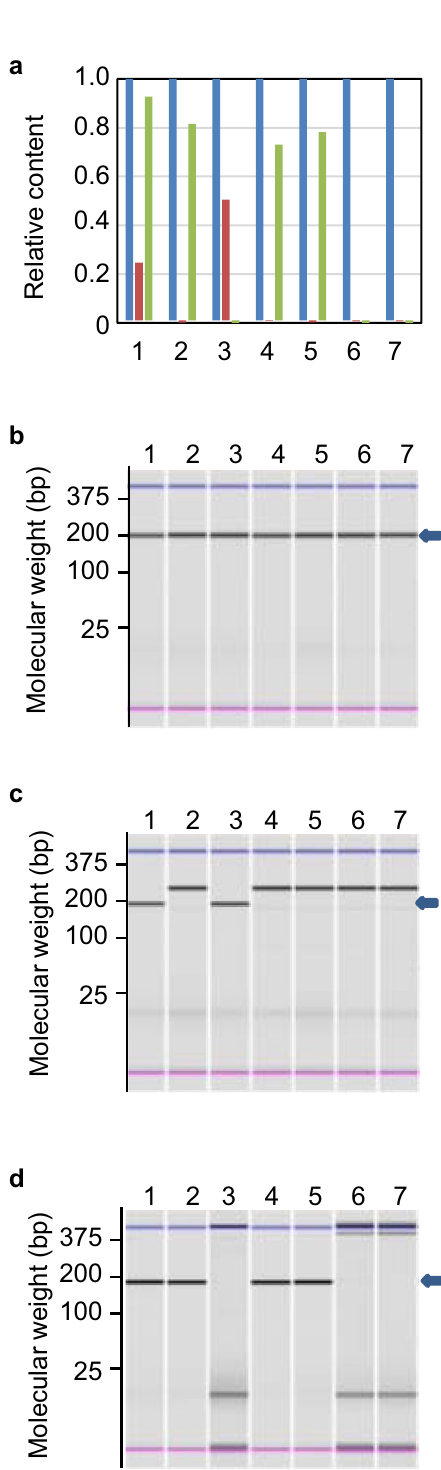
Figure 2. Confirmation of ΔrecA306 polA25 candidate cells using qPCR. ( a ) Relative ratio of the polymerase domain of polA and recA against the 5 ′ –3 ′ exonuclease domain of polA in TK1224 and TK1230 cells. Chromosomal DNA was prepared from the indicated cells using a CellEase Bacteria II kit, and 2 μL of lysed cell solution was analysed for absolute amounts of target DNA. The relative ratios of the polymerase domain of polA and recA were calculated against the 5 ′ –3 ′ exonuclease domain of polA . The blue bar corresponds to the ratio of the 5 ′ –3 ′ exonuclease domain of polA . The red and green bars indicate the relative ratios of the polymerase domain of polA and recA , respectively. Analysed samples were lane 1: AQ10459, lane 2: AQ11756, lane 3: AQ10870, lane 4: AQ1217, lane 5: TK1219, lane 6: TK1230, lane 7: TK1224. ( b – d ) Confirmation of amplified 5 ′ –3 ′ exonuclease domain, polymerase domain, and products of recA , respectively, of polA using ChIP electrophoresis. The qPCR products were analysed using ChIP electrophoresis. The arrowheads indicate either amplified 5 ′ –3 ′ exonuclease ( b ), polymerase ( c ) or recA fragments ( d ). The analysed samples were in the same order as in (a). The original gel images (Fig. S3) were cut for suitability and ease of